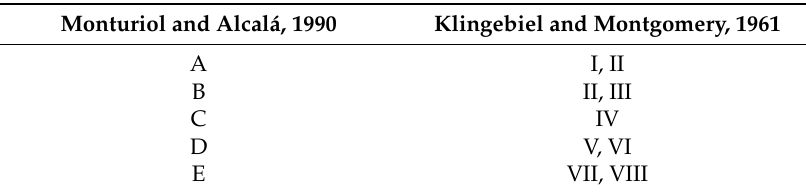
Table 1. Capability classification (Klingebiel and Montgomery’s classification ranges from Class I and II: very fertile soils, to Class VII and VIII: very poor soils). Monturiol and Alcalá,